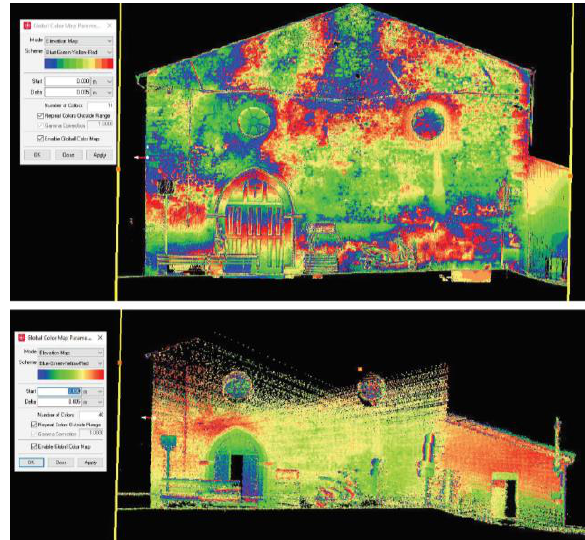
Figure 7 . Calibrating elevation maps on TLS (above) and MLS (below) point clouds.